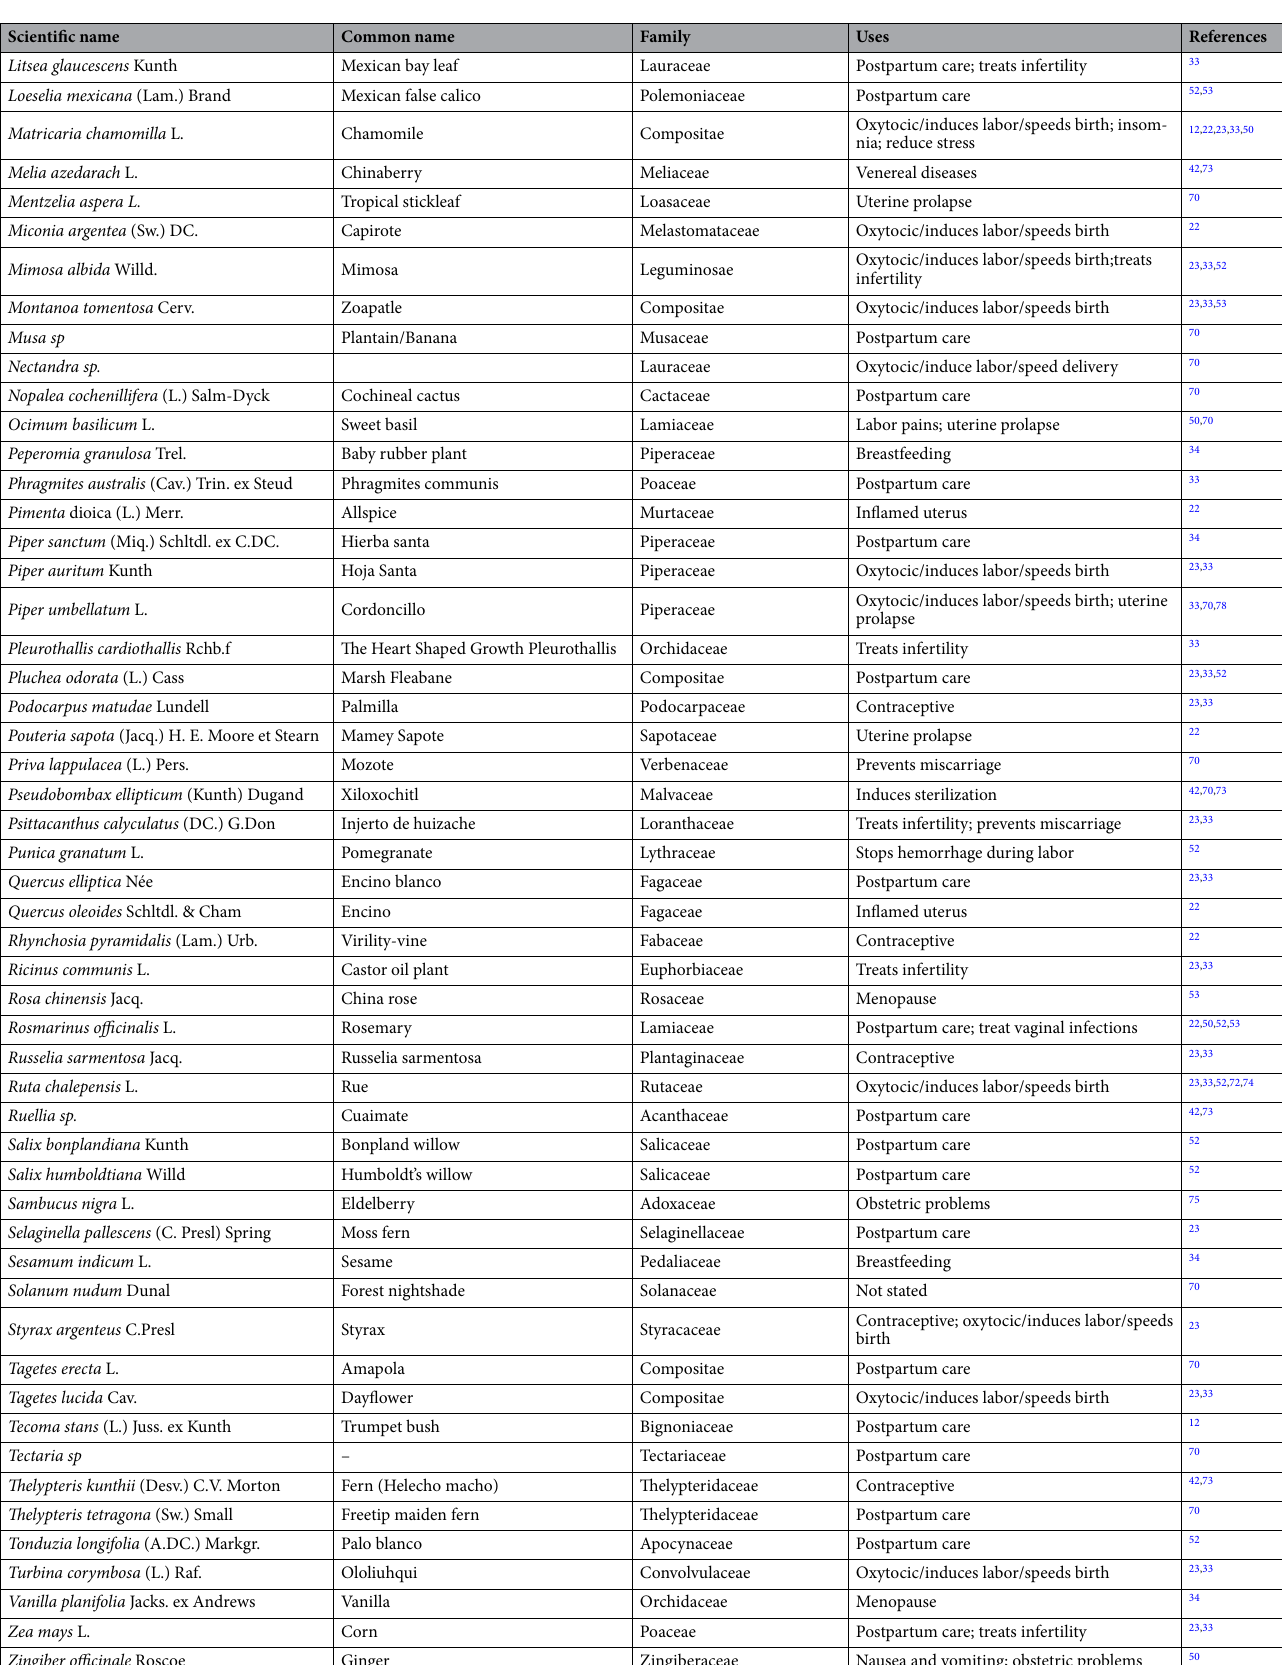
Table 2. Medicinal plants used in Mexican traditional medicine for conception, pregnancy, delivery, post- partum care, menopause and uterine